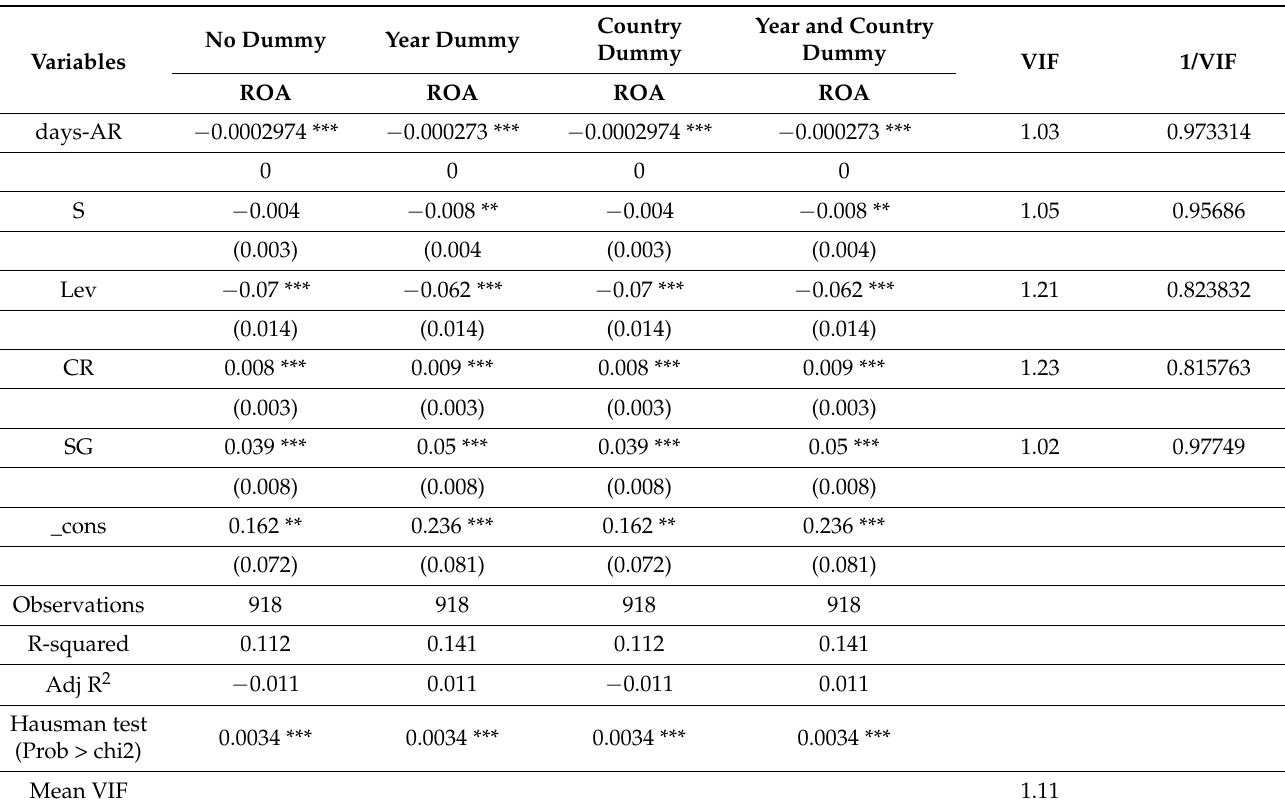
Table 6. Results of the fixed effects of days-AR on ROA, as per panel regression (pre-pandemic period,